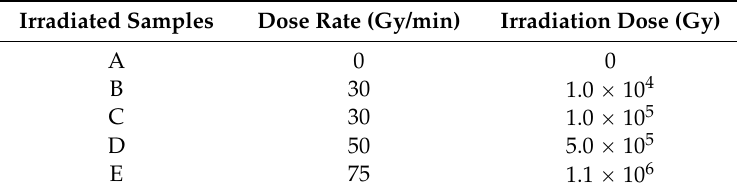
Table 4. Irradiation parameters of the SC4A sample.